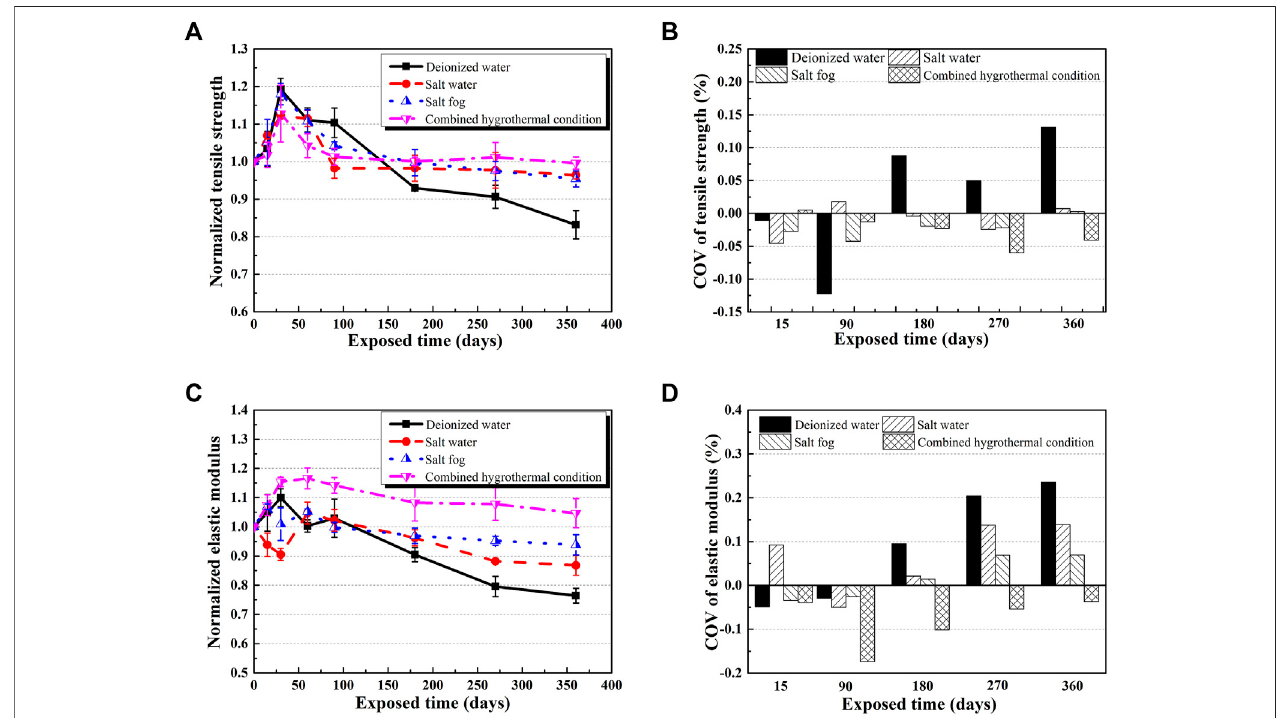
FIGURE 6 | Normalized tensile properties and COV of VE GFRP exposed under different conditions: (A) normalized strength, (B) COV of tensile strength, (C) normalized elastic modulus, and (D) COV of elastic modulus.